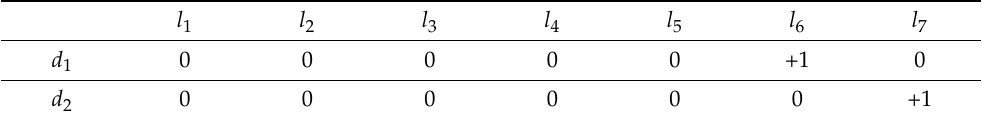
Table 2. Demands-links incidence matrix, I D , for the illustrative example.